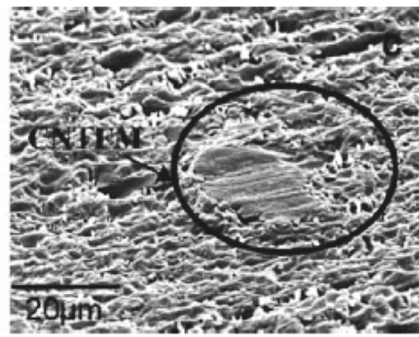
Figure 8: CNT fiber completely sealed by epoxy resin to form CNT- microelectrode [31]. Reprinted with permission from